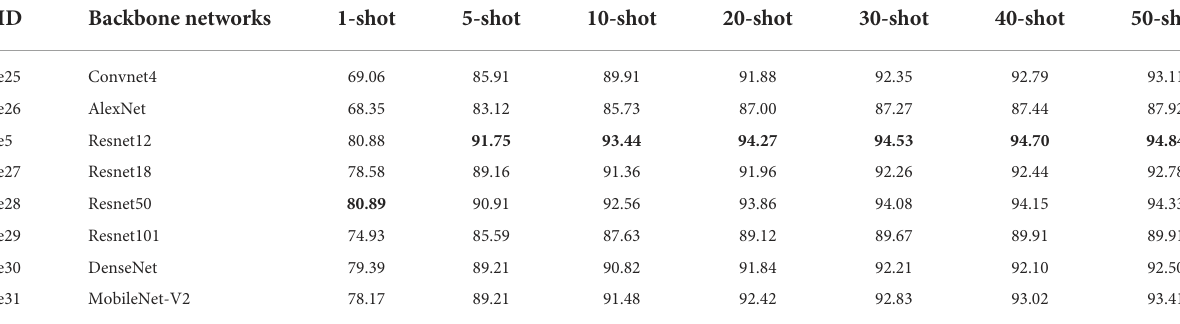
TABLE 8 The results of different backbone